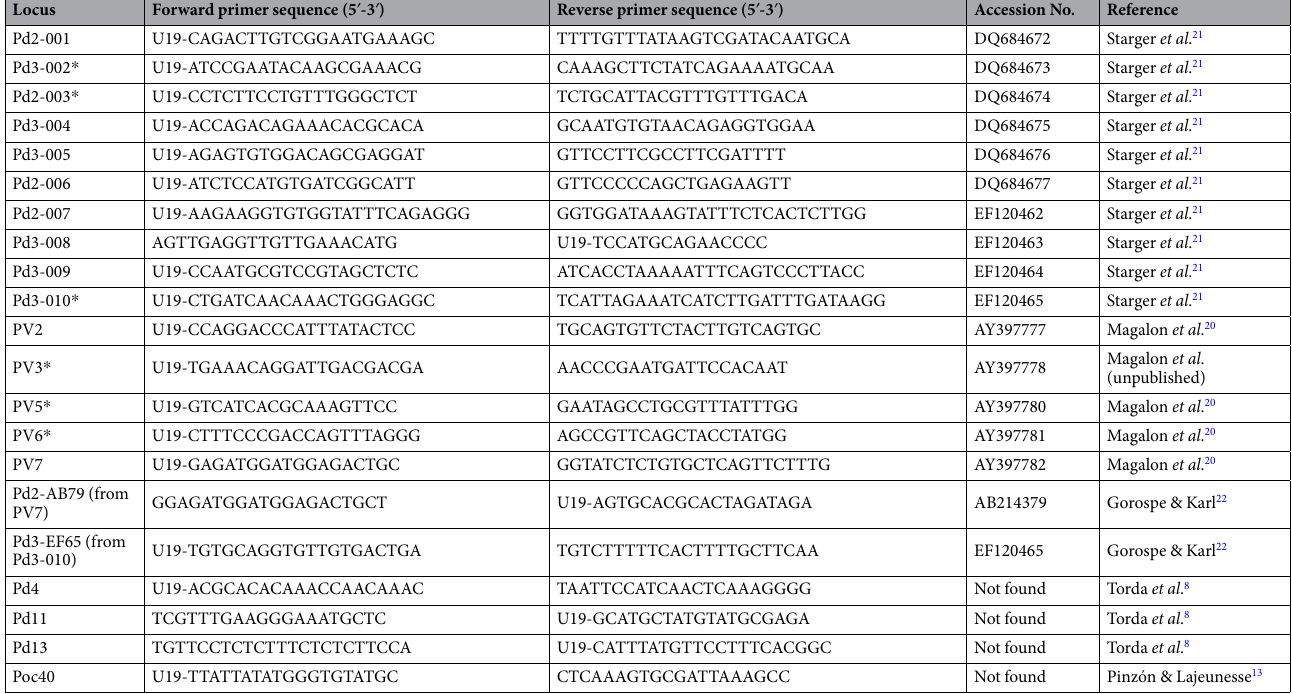
Table 2. Characteristics of previously developed microsatellite loci for Pocillopora : locus name, forward and reverse primer sequences, and GenBank accession number. * We could not confirm the proper amplification for genotyping.